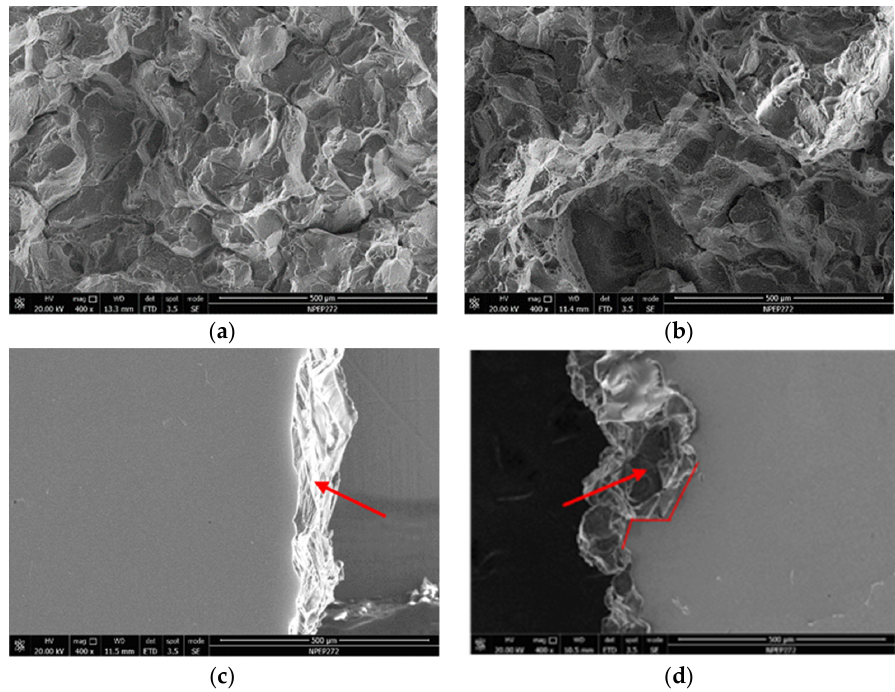
Figure 7. Fracture surfaces of ingot for different grain refiners: ( a , c ) Al ‐ 5Ti ‐ 0.2B grain refiner, ( b , d ) Al ‐ 3Ti ‐ 0.15C grain refiner.